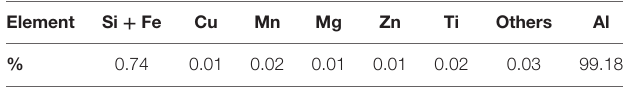
TABLE 1 | AA1200 H14 composition alloy as informed by the supplier.